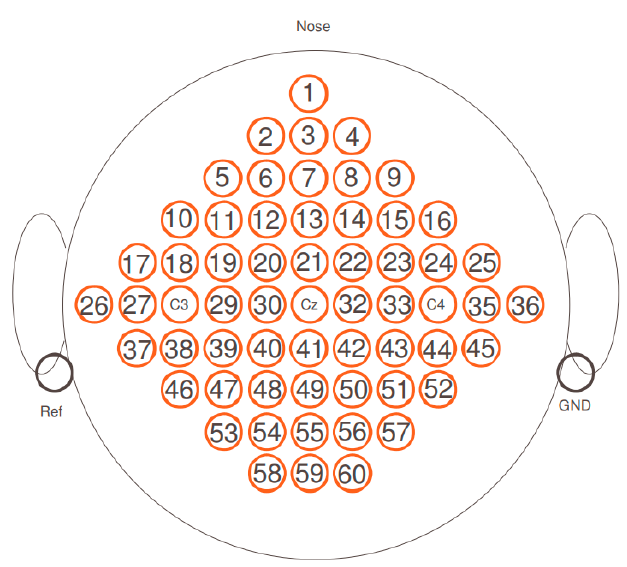
Figure 5. Electrode positions in BCI Competition III dataset IIIa (D3D3a).